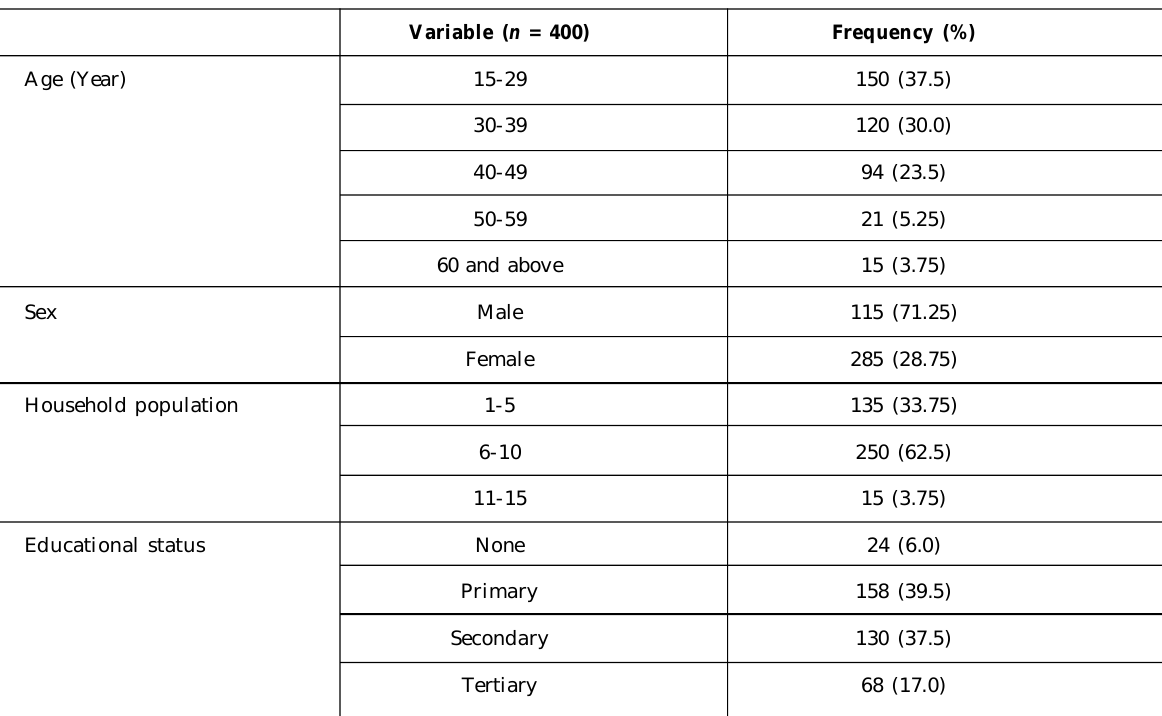
Table 3: Sociodemographic characteristics of the household